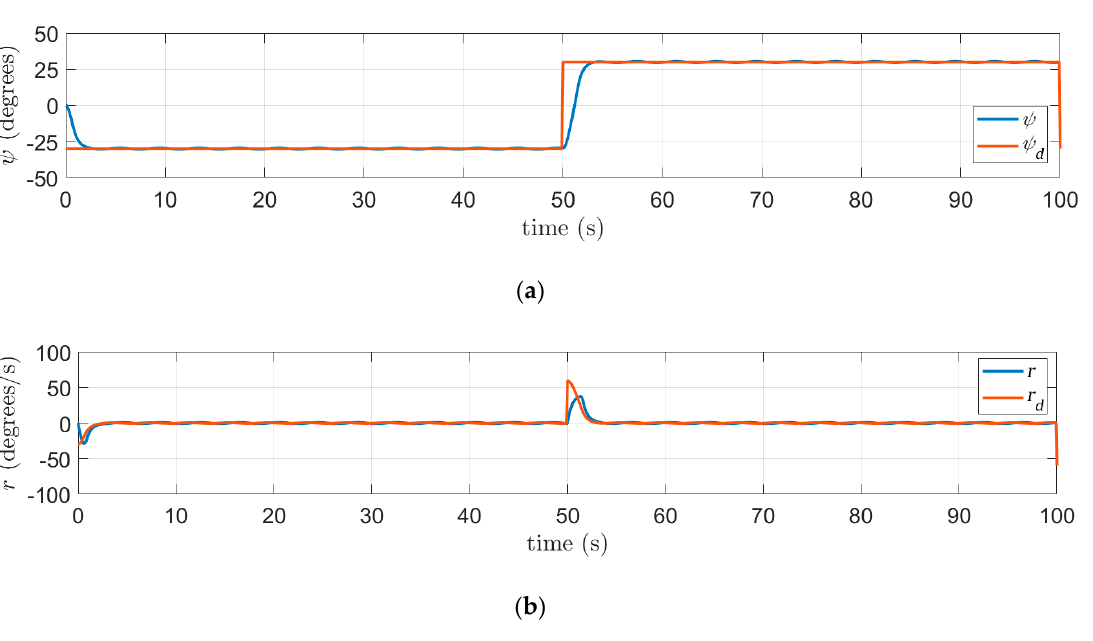
Figure 13. Simulation results of the control input of robust adaptive heading control. In the parameter adaptation, convergence can be observed in Figure 14. All three estimated parameters converge to three constant values in each regulation task, and the real parameters are 𝑎 = 13.1613 , 𝑏 = −18.7246 , and 𝑐 = −3.5488 . The estimation of adaptive control does not converge to real constant parameters. This also shows that once the system enters the boundary layer, the adaptation action decreases, as the error dynamics do not excite the adaptation action and only robust control is used to eliminate the effect of external disturbance.